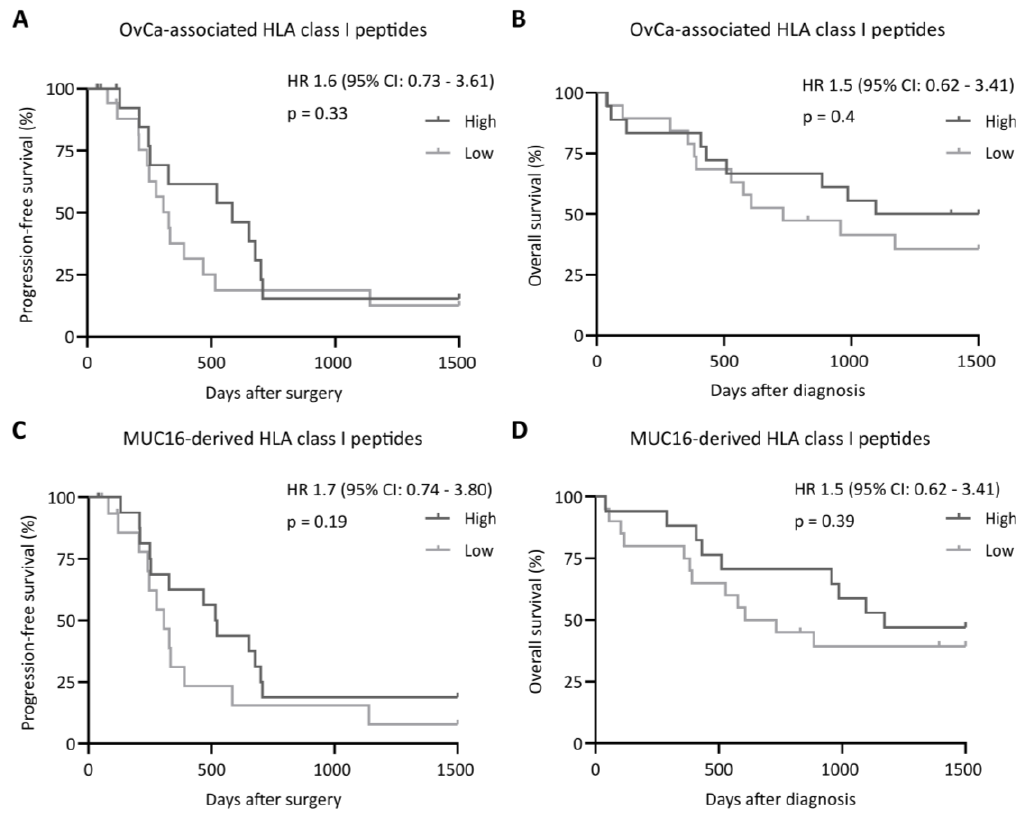
Figure 2. Impact of tumor-associated and MUC16-derived HLA class I-restricted peptide presentation on clinical outcomes. Impact of ( A , B ) OvCa-associated and ( C , D ) MUC16-derived HLA class I- restricted peptide presentation on ( A , C ) progression-free and ( B , D ) overall survival rates, according to antigenic peptide presentation. Kaplan–Meier analysis, log-rank test. Abbreviations: HR, hazard ratio; CI, confidence interval; and p , p